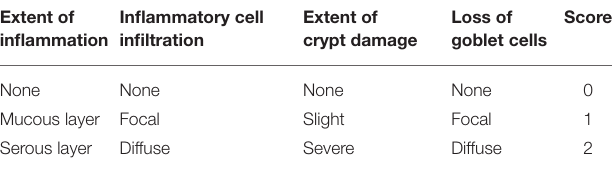
TABLE 3 | The criteria of colonic histopathological